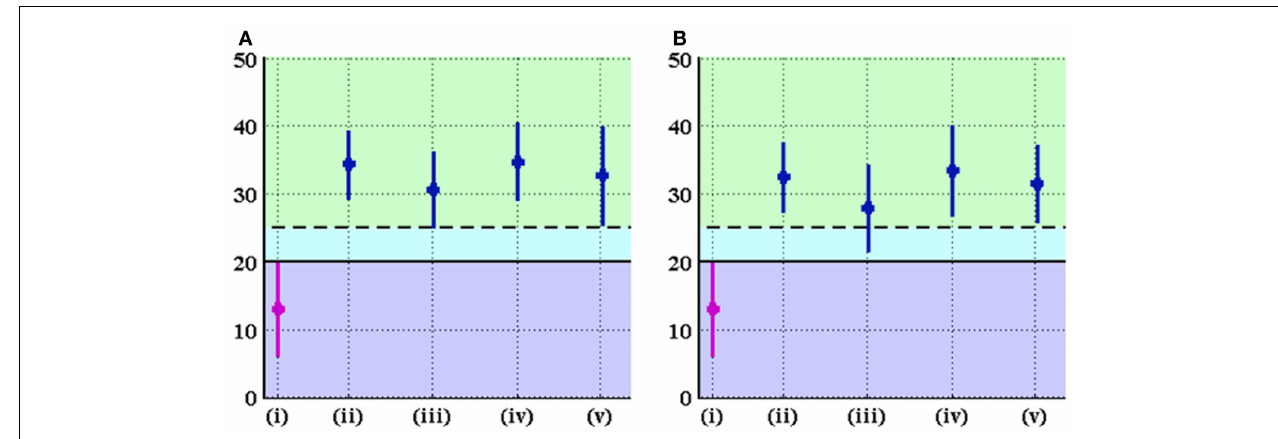
CT-based cartilage thickness models, respectively.The solid line marks the border between the dysplastic and borderline values of the CE angle, while the dashed line represents the border between borderline and normal values of the CE angle. Optimal orientation of the acetabulum results in improvement (increase) of CE angle.